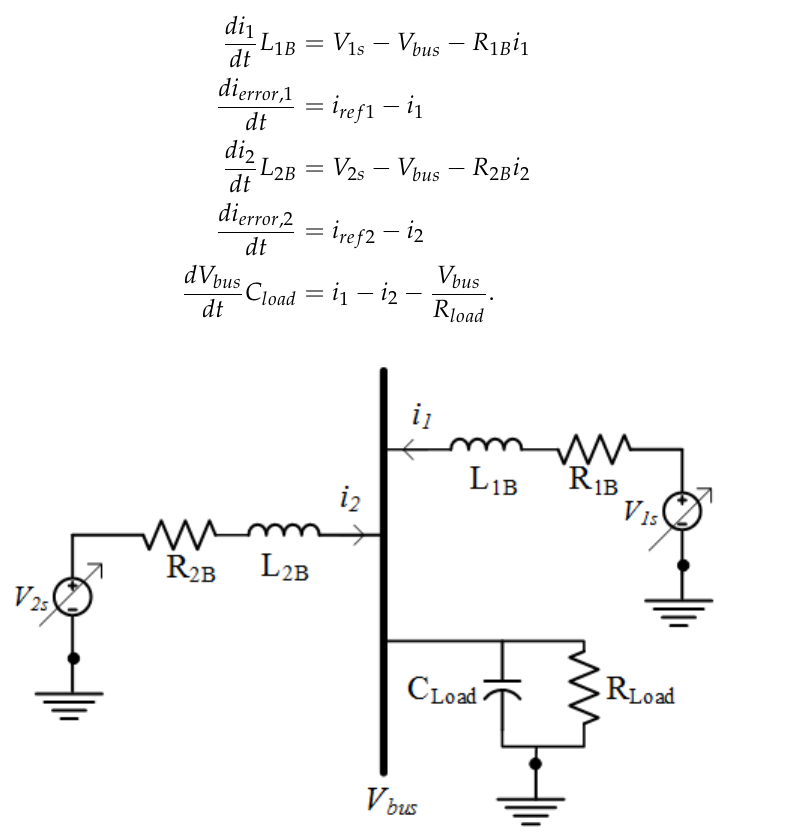
Figure 1. Simple microgrid example with two sources and one